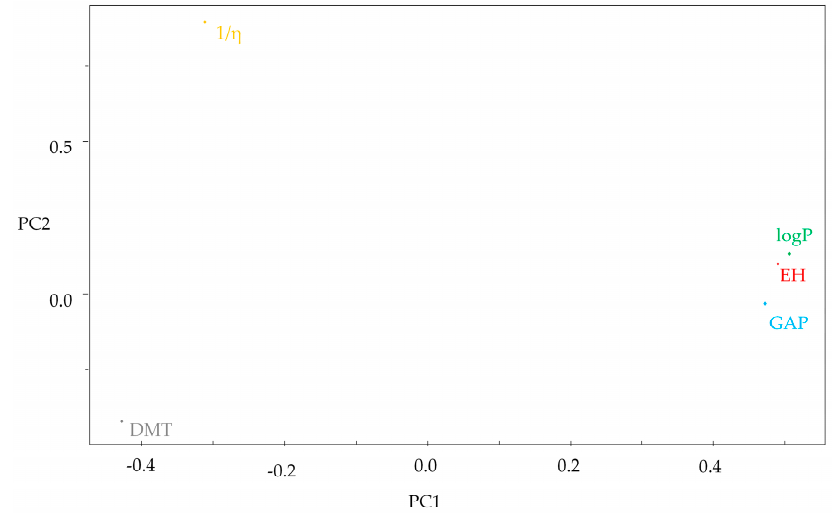
Figure 3. The plot of PC1–PC2 scores for Curatella americana chemical constituents. Red color indicates less reactive compounds and blue color indicate more reactive compounds.